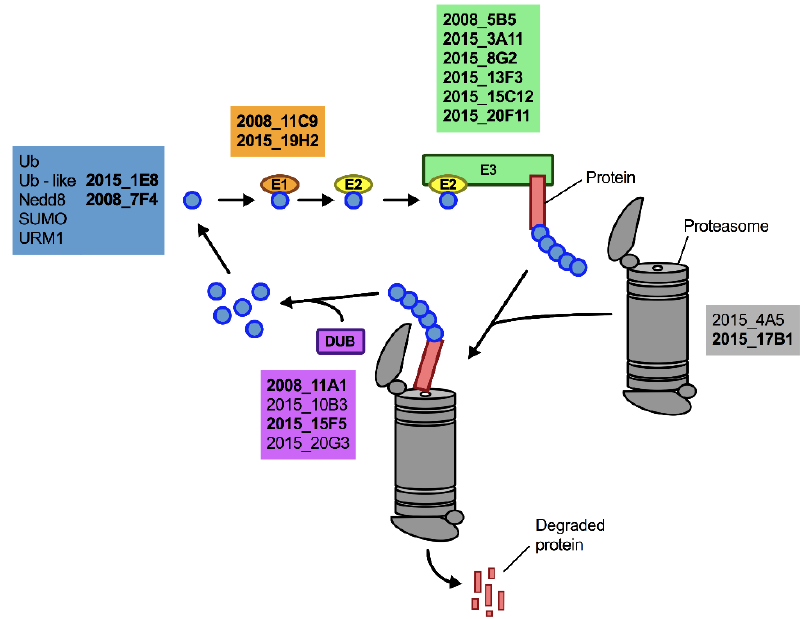
FIGURE 5: The ubiquitin/proteasome-associ- ated mutants identified in the lithium screen have defects in proteins implicated in several stages of the ubiquitin/proteasome system. The strains defective in proteins be- longing to a specific functional category of the ubiquitin/proteasome system (for example E1, or DUB) are color-coded and indicated based on their strain designation at the